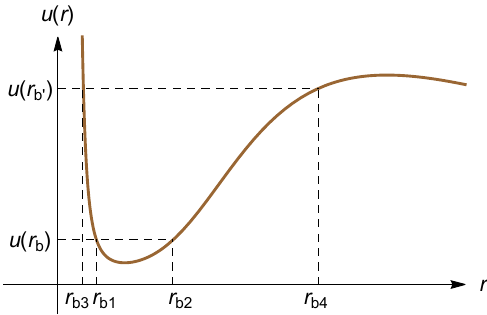
Figure 12 . Turning points of the function u ( r ) for two different values of the impact parameter, namely b 0 < b and u ( r 0 ) > u ( r ) . As the plot shows, | r . When b decreases, b b 4 − r b 3 | > | r b 2 − r b 1 | b according to (A.2), u ( r ) → u ( r ) and as consequence | r . Thus, in this b b 0 b 2 − r b 1 | → | r b 4 − r b 3 | situation the bound state size increases. The opposite situation is also true. When b increases, ) → u ( r ) , | r and the bound state size u ( r 0 b b 4 − r b 3 | → | r b 2 − r b 1 | b